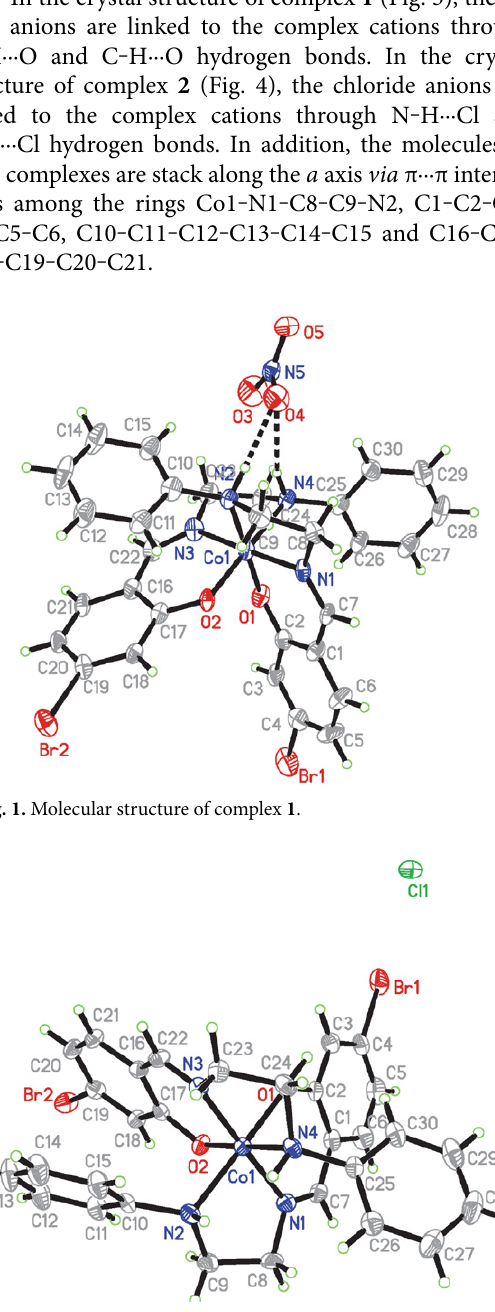
Fig. 2. Molecular structure of complex 2 .